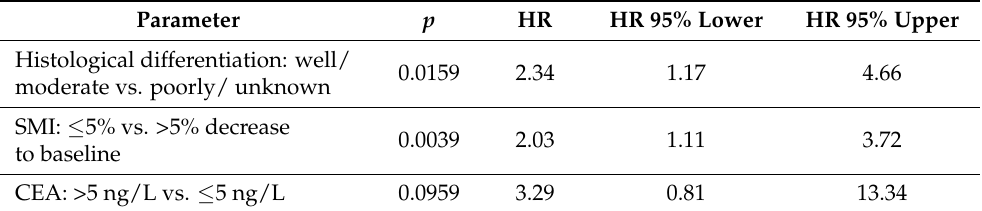
Table 6. Multivariate analysis of overall survival.